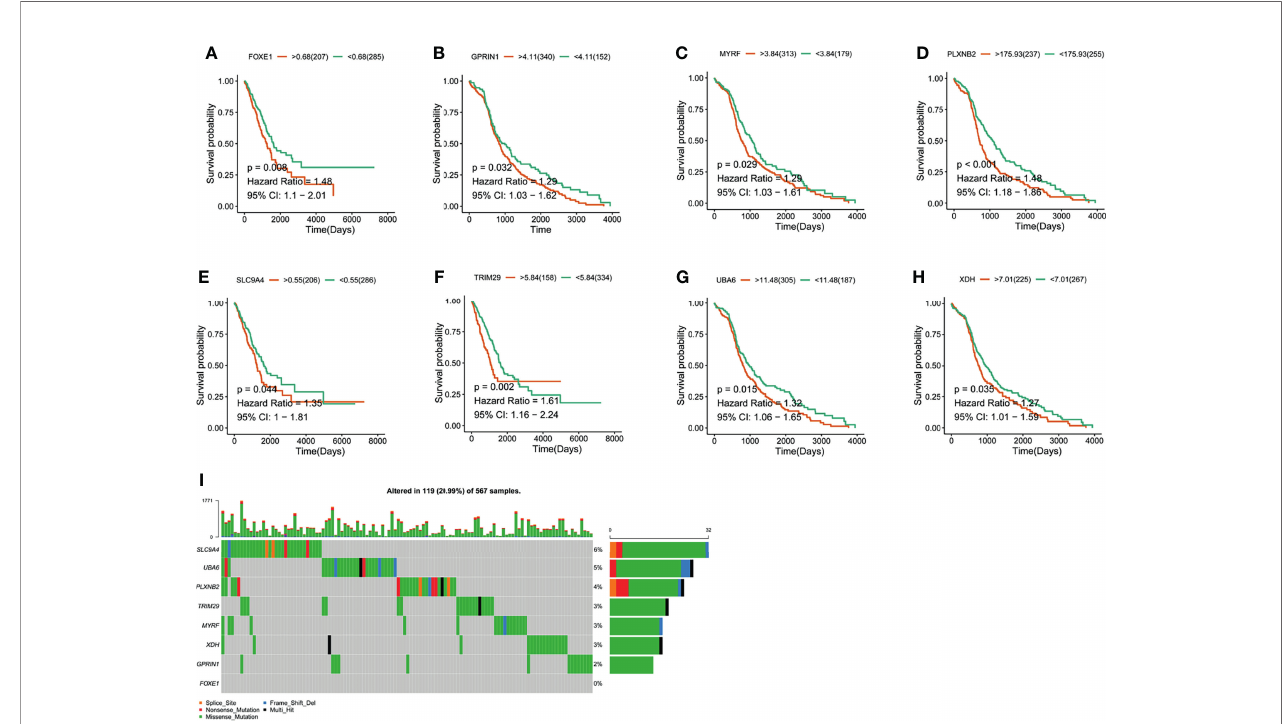
FIGURE 2 | The validation of LUAD-related immune biomarkers by predicting prognosis. (A – H) Kaplan – Meier curves of LUAD patients who have mutations in FOXE1 (A) , GPRIN1 (B) , MYRF, (C) , PLXNB2 (D) , SLC9A4 (E) , TRIM29 (F) , UBA6 (G) , and XDH (H) . (I) Potential tumor biomarker-related gene (494 samples) with high mutation in